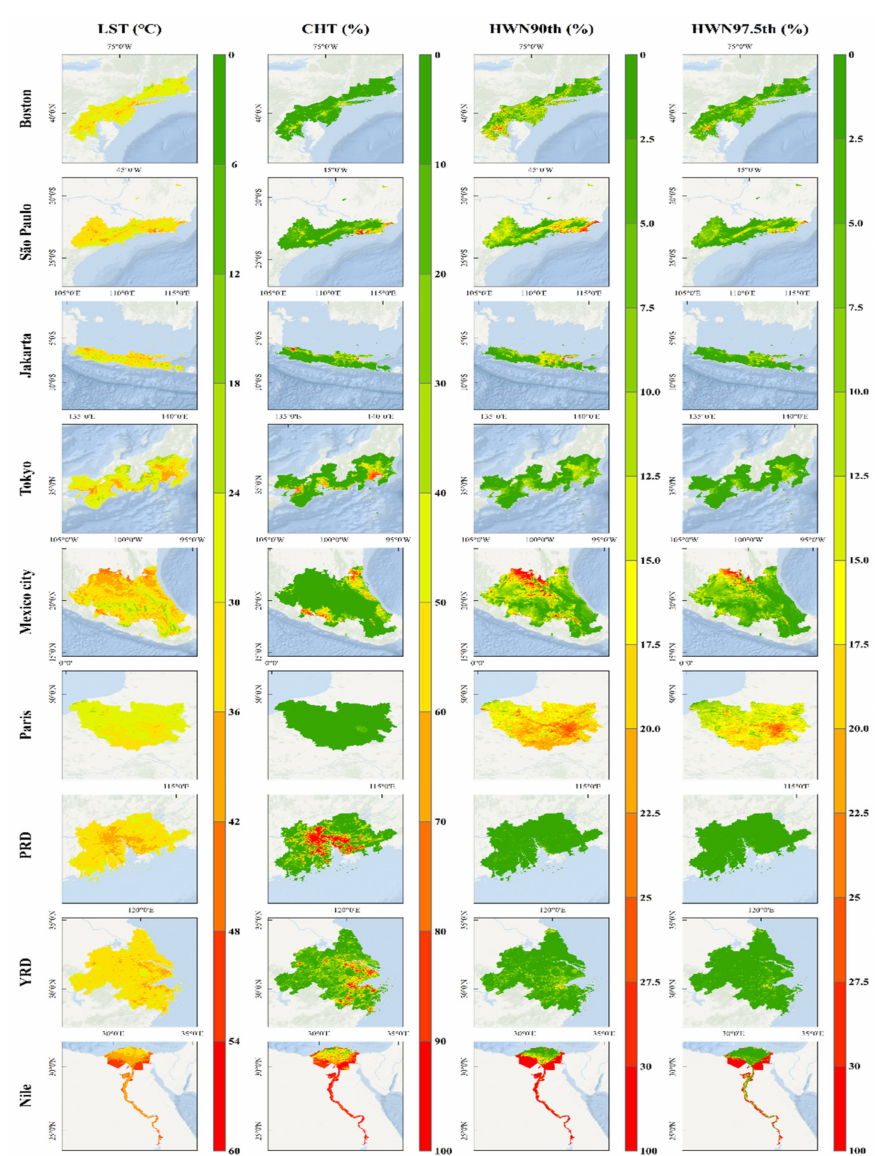
Figure 5. Spatial distribution of mean LST, CHN, and HWN over the study period in the 9